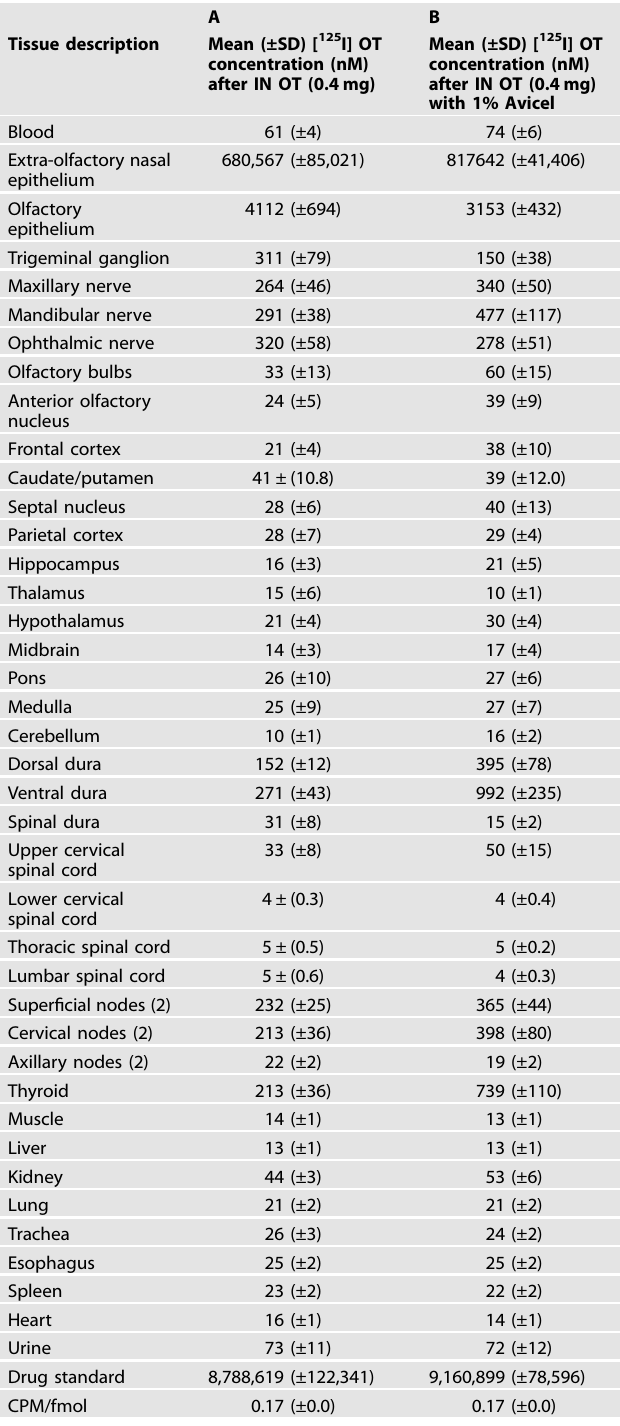
Table 1. Gamma counts representing [125I] oxytocin (OT)